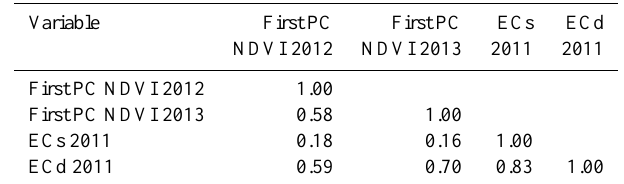
Table 7. Correlation matrix ( R 2 ) between first principal compo- nents of 2012 and 2013 growing seasons and apparent electrical conductivities, shallow and deep, interpolated data of